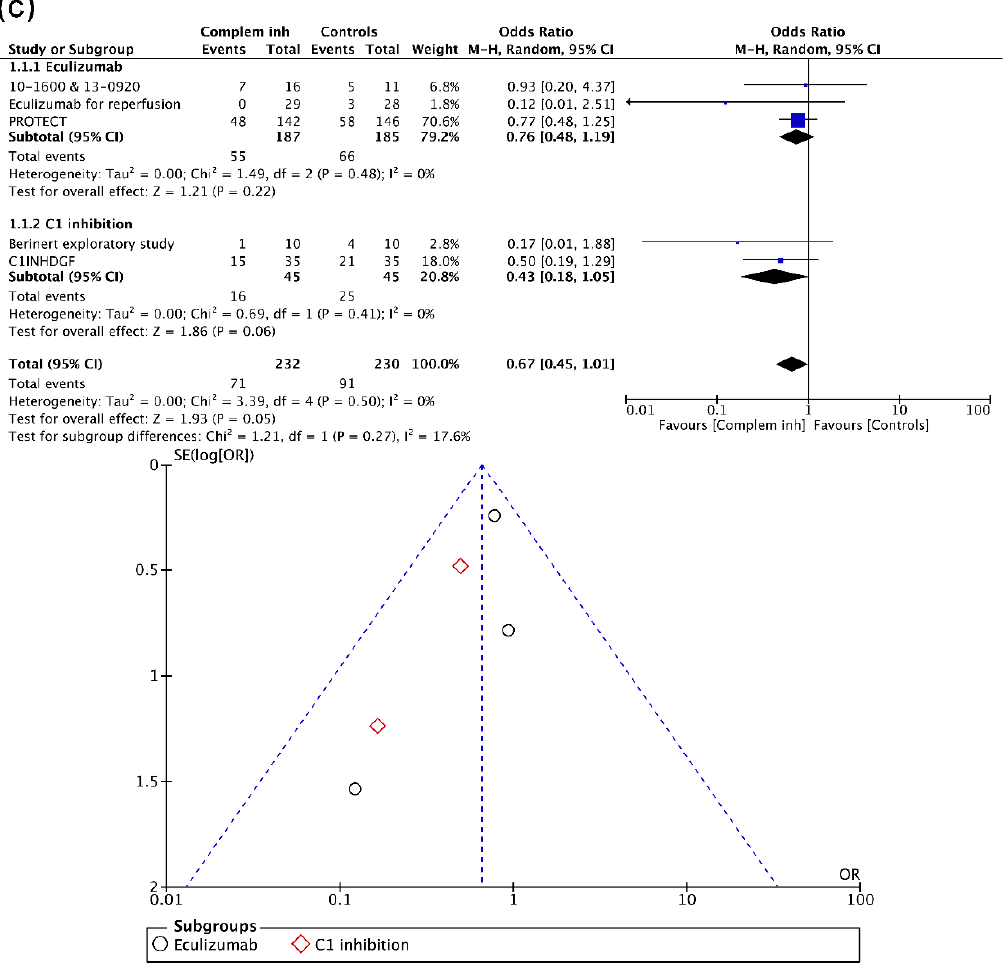
Figure 6. Forest and funnel plots showing effect estimates of complement inhibition (clinical trials) corresponding to ( a ) the treatment of rgMG crises, ( b ) the prevention of new acute AMR episodes, and ( c ) the prevention of DGF after kidney transplantation. AMR, antibody-mediated prevention; CI, confidence interval; M–H, Mantel–Haenszel test; PBO, placebo; rgMG, refractory generalized myasthenia gravis; SE, standard error.